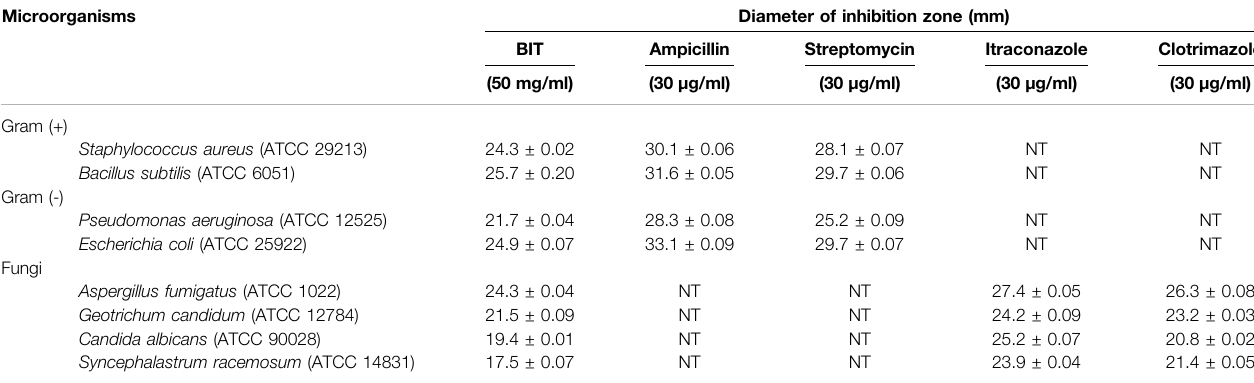
TABLE 1 | Mean inhibition zones of BIT against different pathogens determined by the agar diffusion